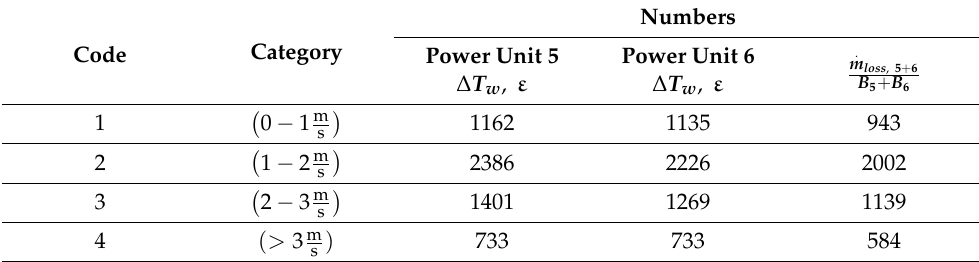
Table 1. Wind velocity categories and their numbers.